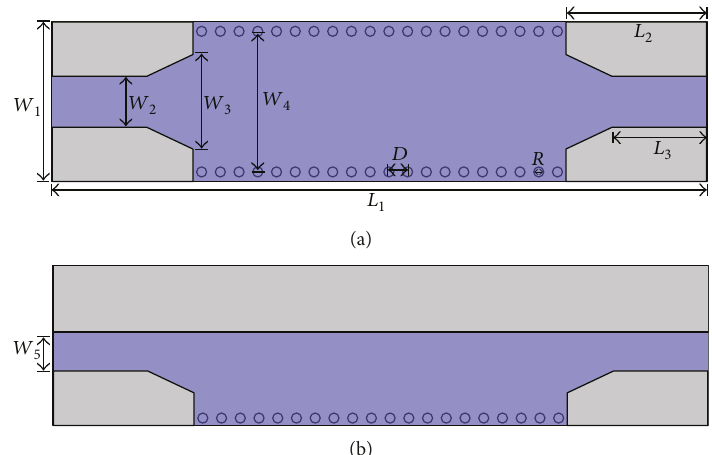
Figure 1: Substrate-integrated waveguide layout fabricated by Rogers 4350 substrate. (a) Substrate-integrated waveguide; (b) half-mode substrate-integrated waveguide.